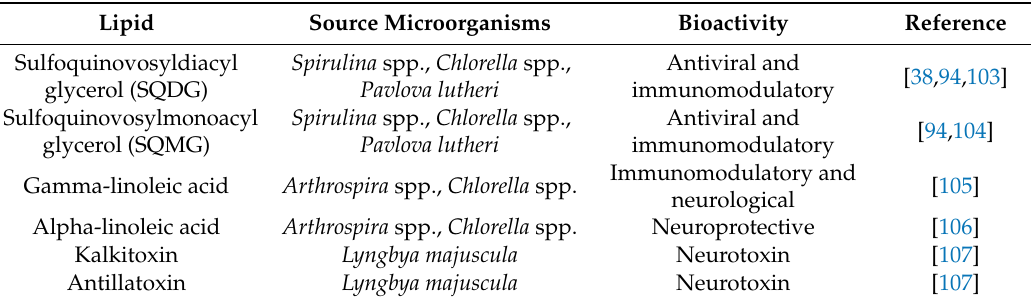
Table 2. Examples of bioactive lipids from bacteria and microalgae. Lipid Source